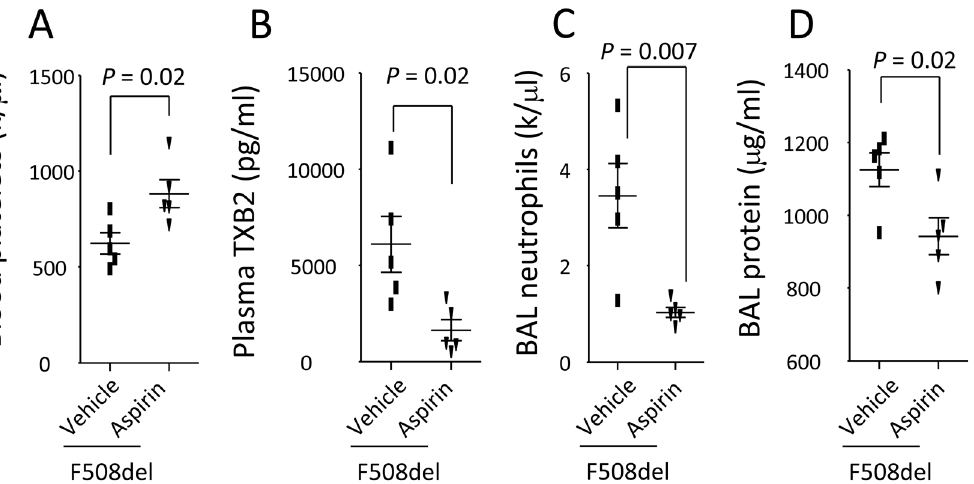
Figure 2. Prevention of platelet aggregation by Aspirin reverses thrombocytopenia and reduces LPS-induced lung inflammation in F508del mice. A. Pretreatment with Aspirin increased blood platelet counts; B. Pretreatment with Aspirin reduced plasma TXB2 levels in LPS- challenged F508del mice compared to LPS-challenged F508del mice receiving vehicle; C–D. Administration of aspirin reduced BAL neutrophils and protein levels in LPS-challenged F508del mice compared to LPS-challenged F508del mice receiving vehicle. N=5 in each group. Data were analyzed by t-test and presented in mean 6 SD. P values are listed on each panel.